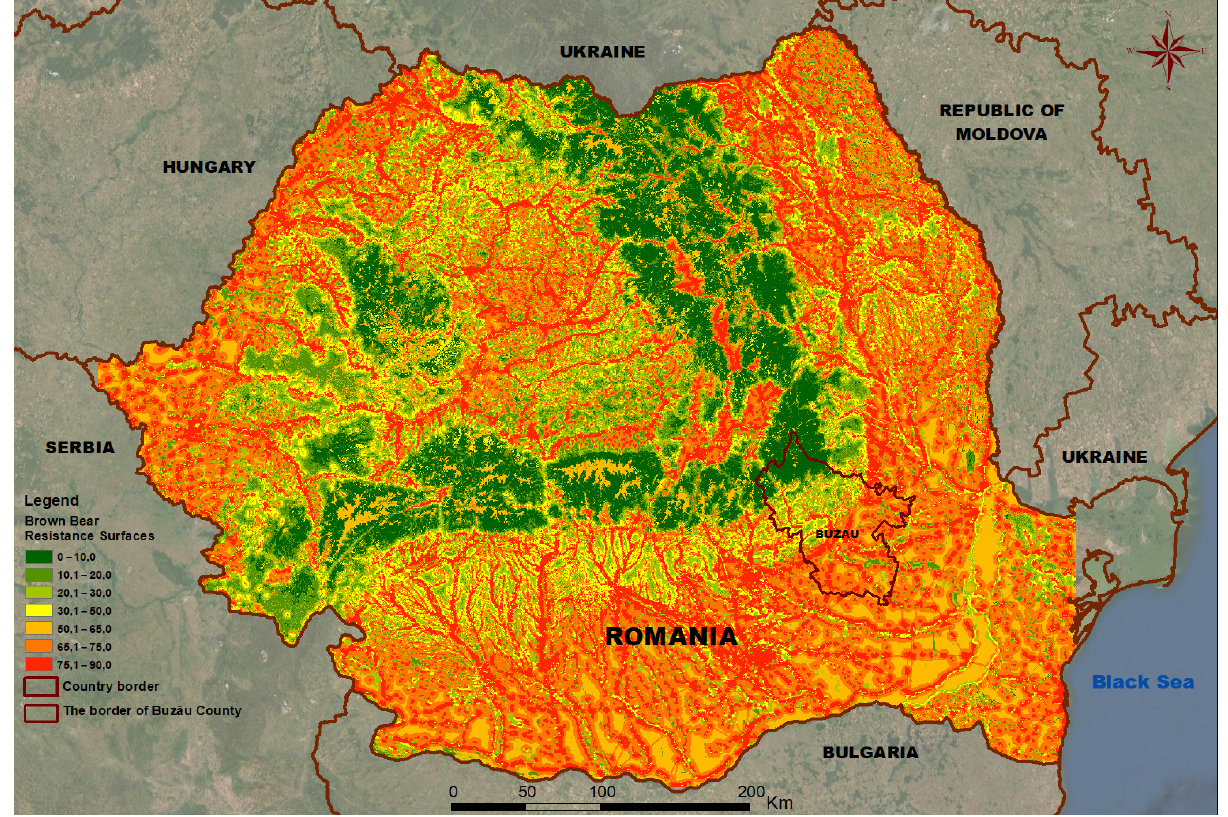
Figure 4. Map of the resistance to movement of the brown bear in Romania. The map presents resistance surfaces for the brown bear, which represent the degree to which landscape features impedes/facilitates its movement (modeled with ArcGIS 10.6 Linkage Mapper).